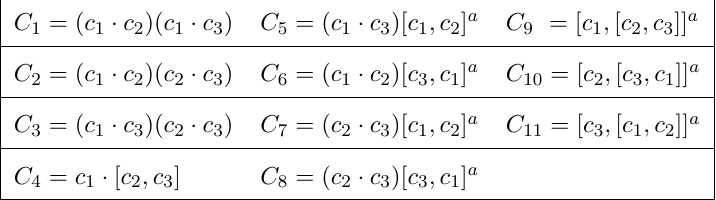
Table 3 . List of the color numerators relevant for worldline degrees of freedom at next-to-leading order. The (cid:12)rst column is color singlet and used for the trajectory deviation, while the rest carries an adjoint index and used in the color deviation. The dual color numerators follow similarly. The last three satisfy Jacobi identity C 9 + C 10 + C 11 =